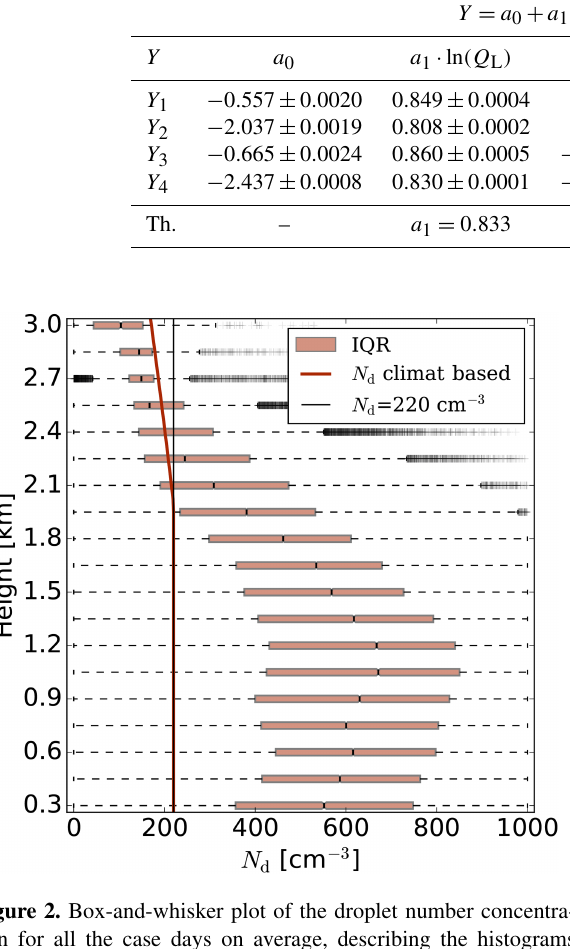
Figure 2. Box-and-whisker plot of the droplet number concentra- tion for all the case days on average, describing the histograms of N d simulated for different model levels by the double-moment scheme of ICON-LEM. Boxes illustrate interquartile range (IQR), dark red line denotes the climatology-based N d profile adopted by ECHAM, and the thin black line demonstrates the constant N d pro- file of 220cm − 3